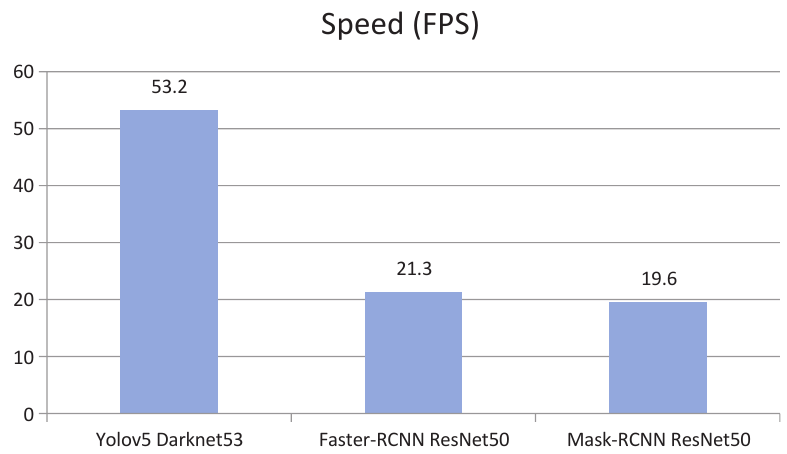
Figure 15. The speed of Yolov5, Faster-RCNN and Mask-RCNN models for insect pest detection.